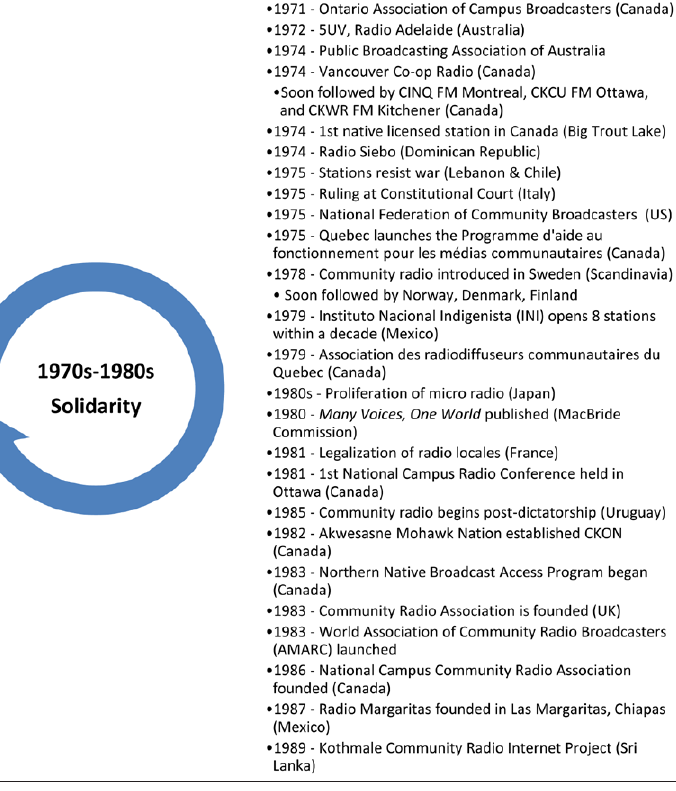
Figure 4: Solidarity period of community radio